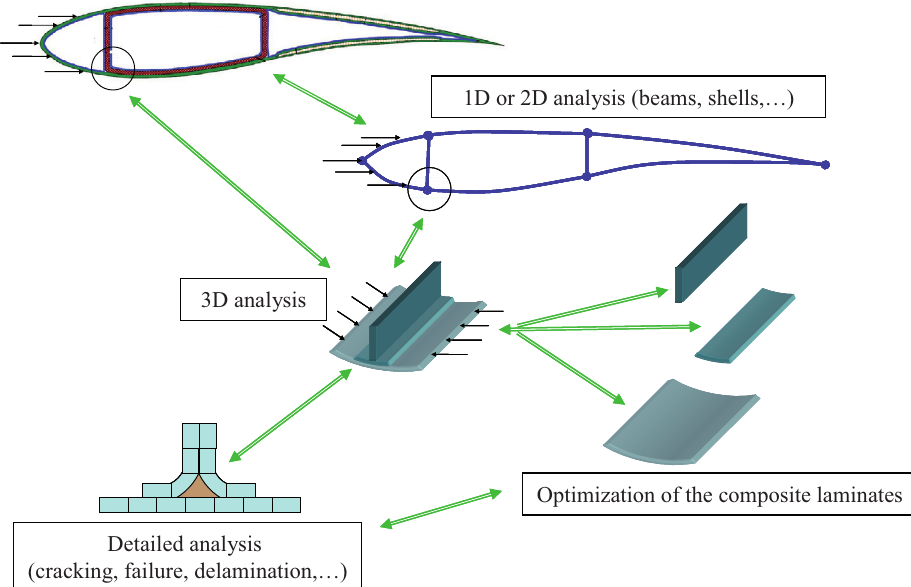
Fig. 3. Multilevel strategy for structural optimisation in the aeronautical